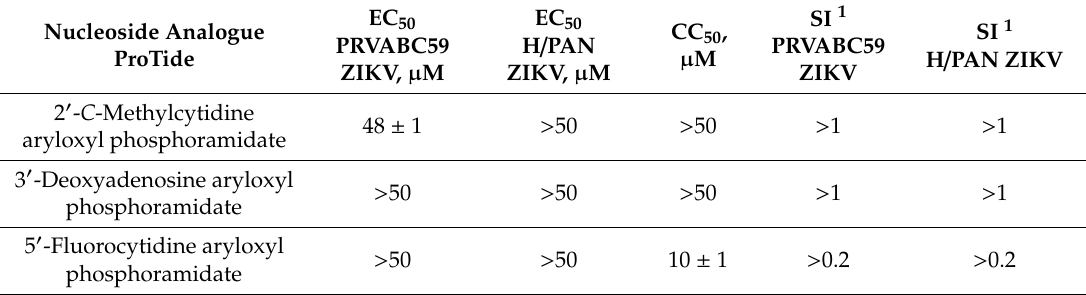
Table 1. Anti-ZIKV activity and toxicity of nucleoside analogue ProTides in neural stem cells. EC 50 EC 50 Nucleoside Analogue PRVABC59 H / PAN ProTide ZIKV, µ M ZIKV, µ